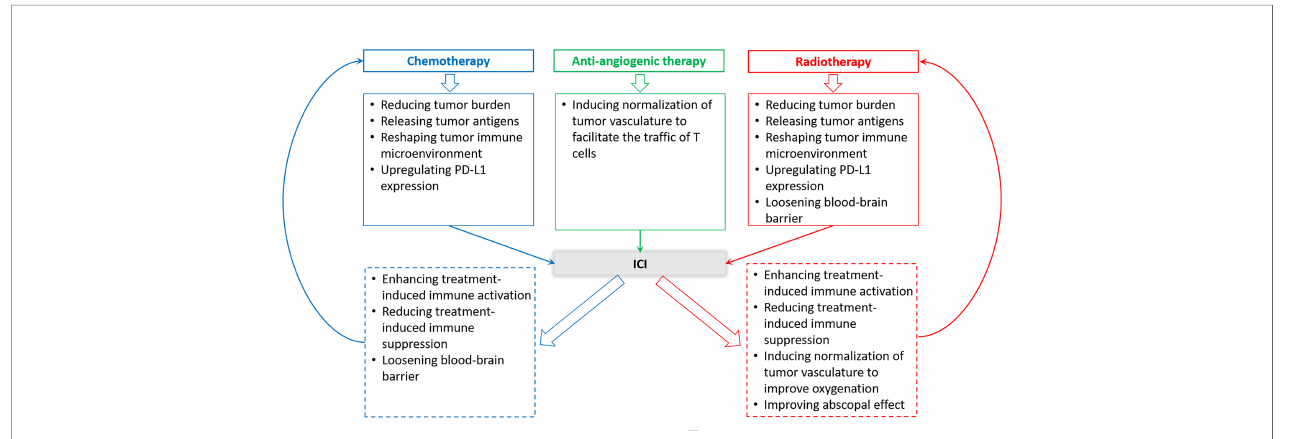
FIGURE 2 | Rationality of ICI therapy and other therapies combination in the treatment of NSCLC patients with